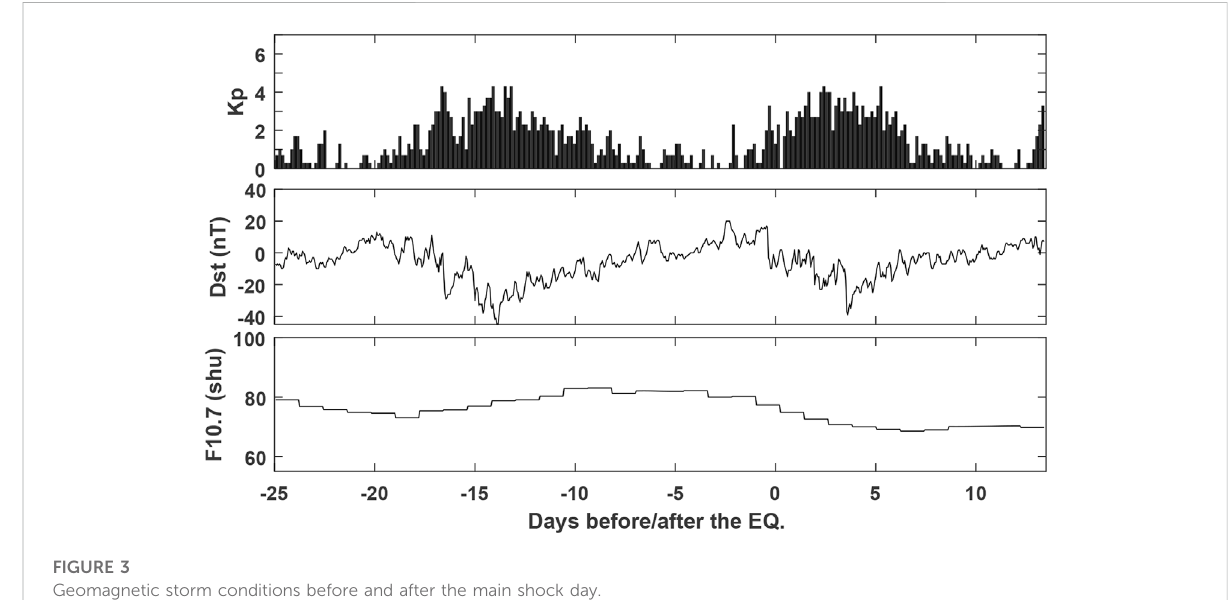
FIGURE 3 Geomagnetic storm conditions before and after the main shock day.